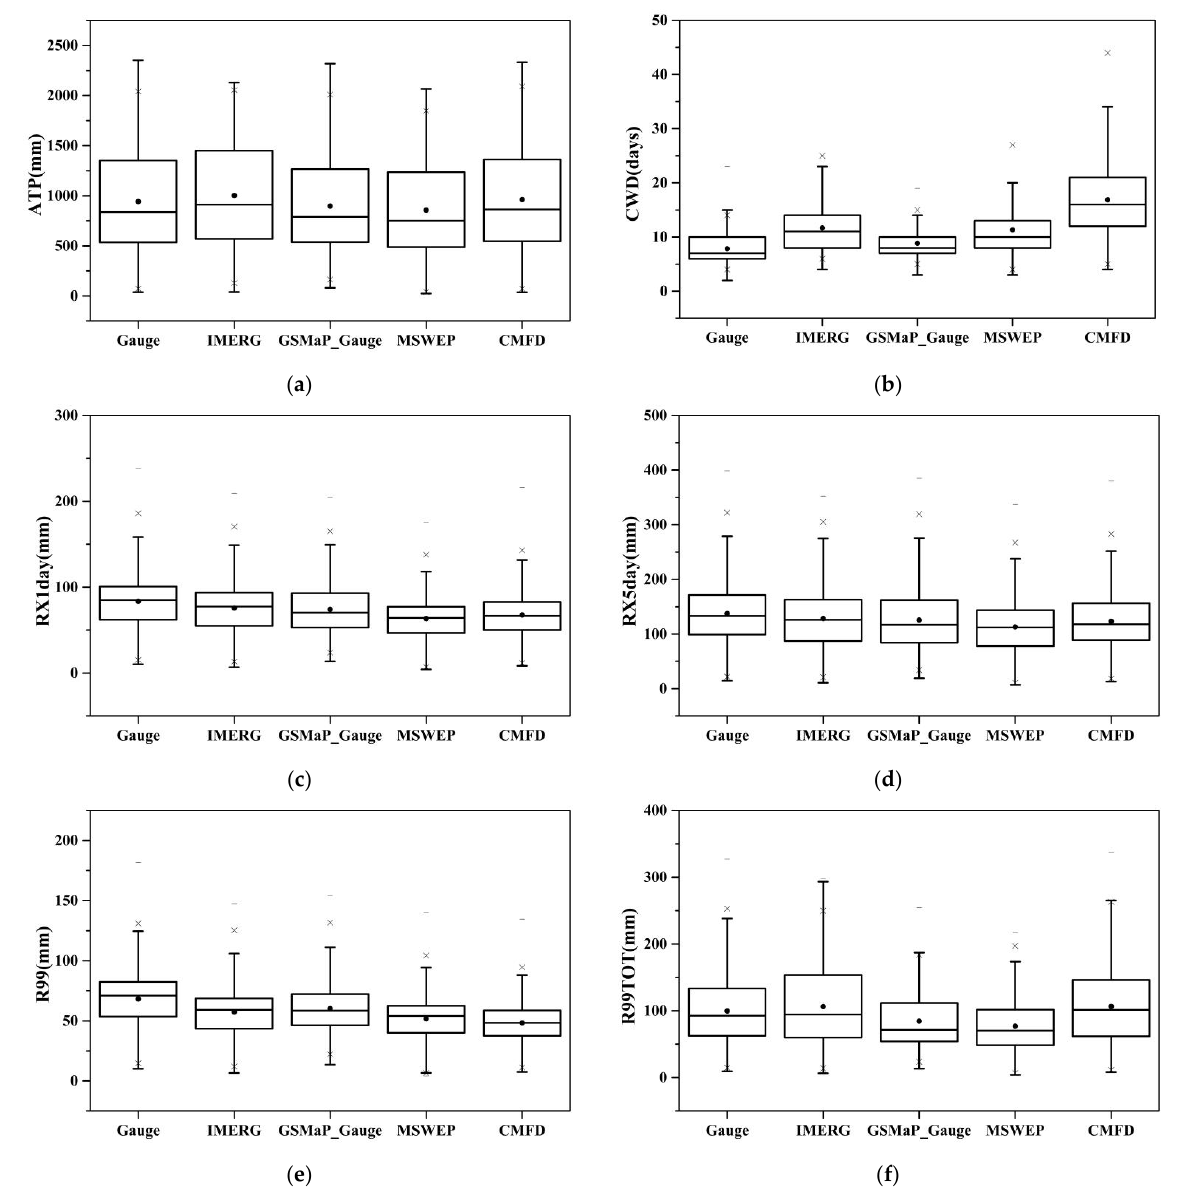
Figure 4. Boxplots for the extreme precipitation indices: ( a ) ATP, ( b ) CWD, ( c ) RX1day, ( d ) RX5day, ( e ) R99, and ( f ) R99TOT for the rain gauge data and the four SPPs data at 821 urban gauges.